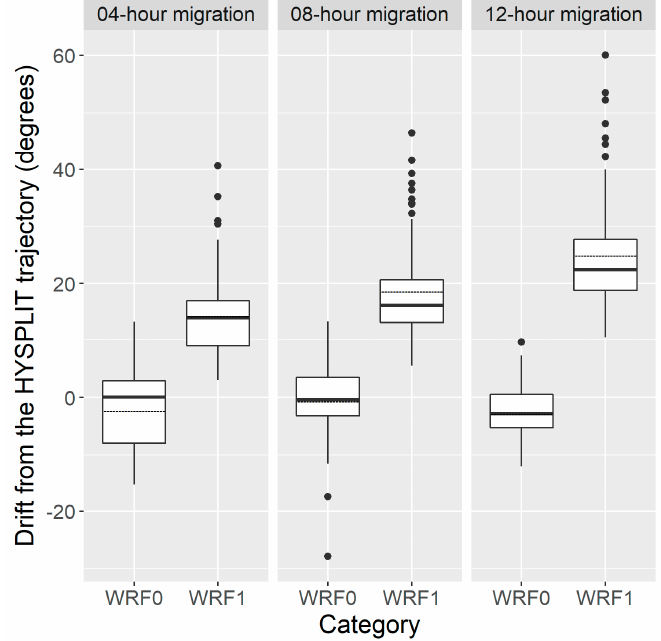
Figure 5. The degrees of trajectory direction of H. zea migration trajectories calculated by WRF0 and WRF1 drifting from the standard Hybrid Single-Particle Lagrangian Integrated Trajectory (HYSPLIT) trajectory of three flight durations, respectively. The bottom and top of the box indicate the lower and upper quartile values, respectively. The horizonal solid black line shows the median for each category, and the black dashed line represents the mean. Whiskers indicate the 5th and 95th percentiles, while the black circle represents the outlier.